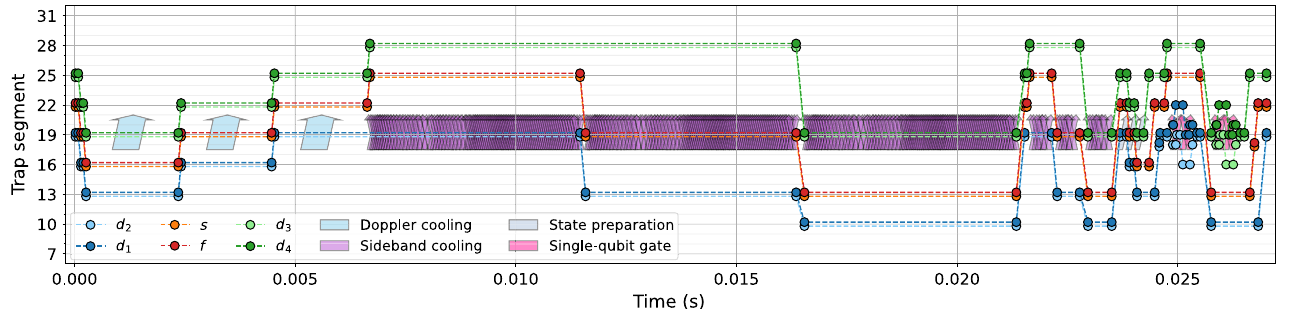
FIG. 12. Shuttling of the register preparation sequence part described in Sec. A 2. The two-qubit building blocks sequentially undergo Doppler laser cooling (light blue arrows, up to 6 ms), pulsed sideband cooling on all transverse modes (purple arrows, up to 23 ms), optical pumping (light blue arrows, at 24 ms), and optional qubit rotations for preparation of arbitrary logical states of the data qubits (pink arrows, up to 26